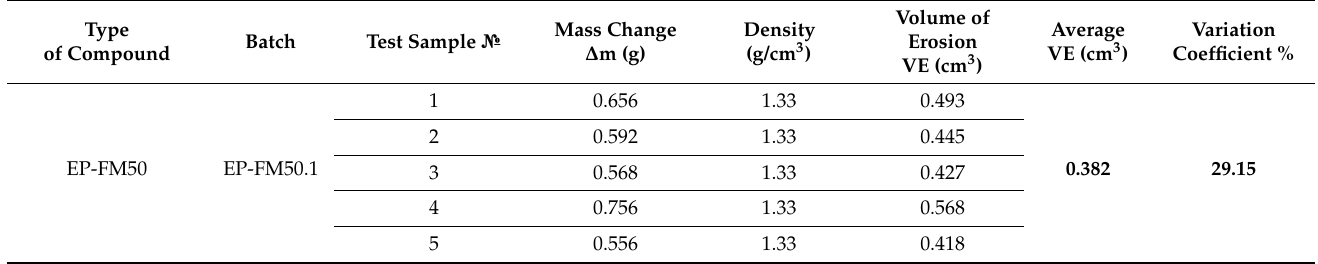
Table A19. Wear of filled epoxy binder (EP-FM50) at 23 ◦ C at an impingement angle of 90 ◦